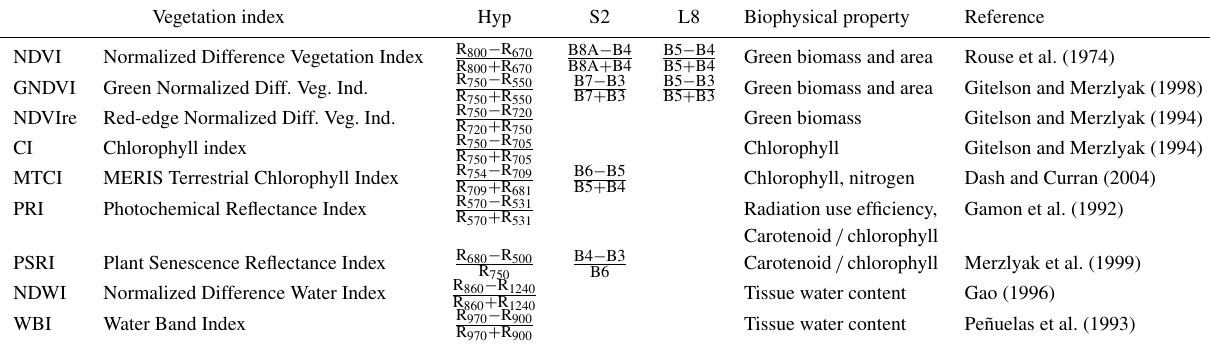
Table 2. Selection of vegetation indices adopted in this study with their formulation using hyperspectral (Hyp) grouped bands, S2 or L8 simulated sensors, biophysical properties represented according to the literature and original bibliographic